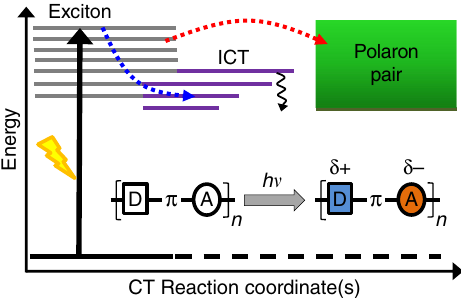
Fig. 1 Energetics of photoinduced processes in neat low-bandgap donor- π - acceptor copolymers. Photogenerated excitons can lead to ultrafast intramolecular charge transfer (ICT) and polaron pair